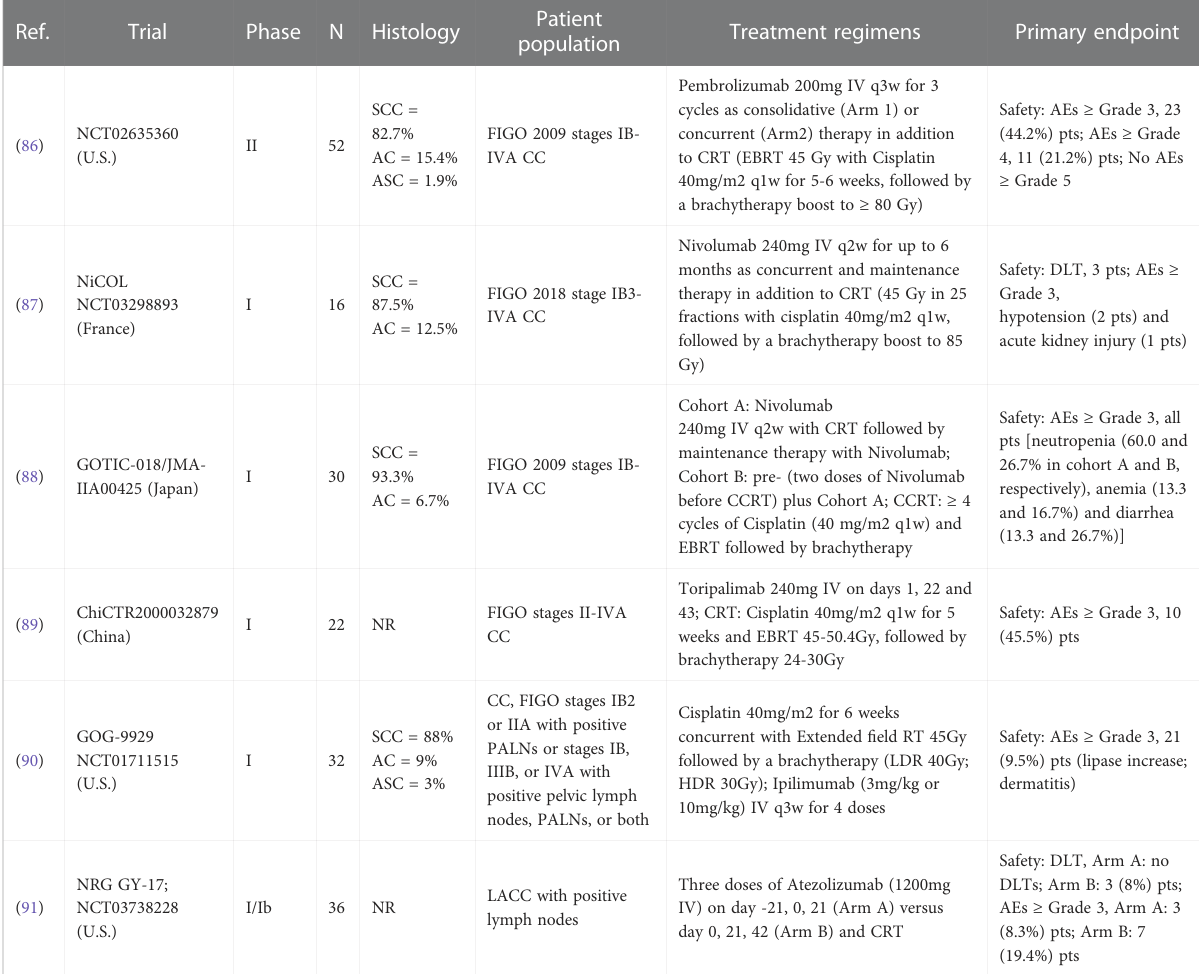
Ref. Trial Phase